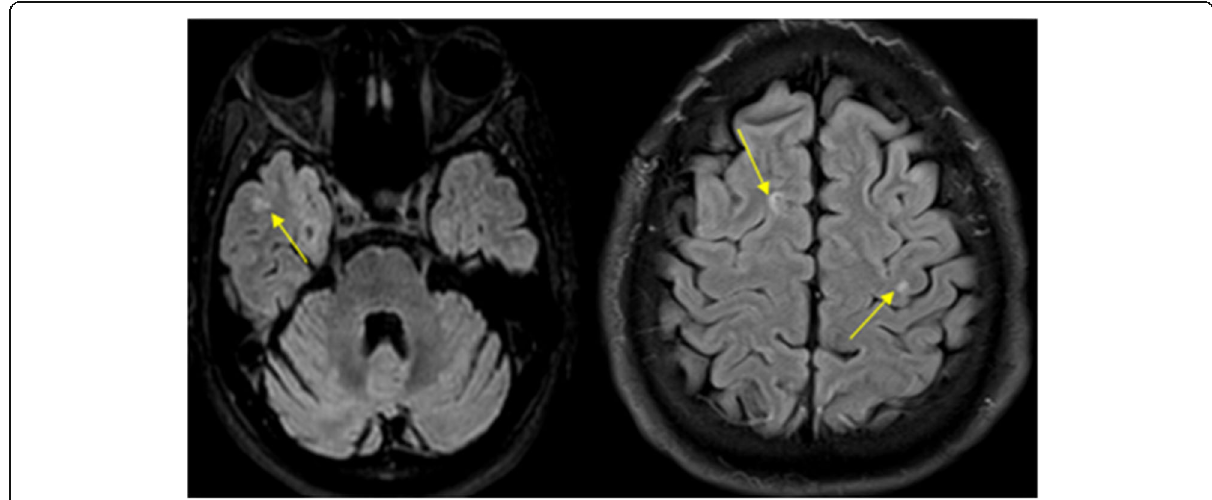
Fig. 4 Axial 3D FLAIR sections showing juxtacortical white matter lesions abutting the cortex with no white matter in between